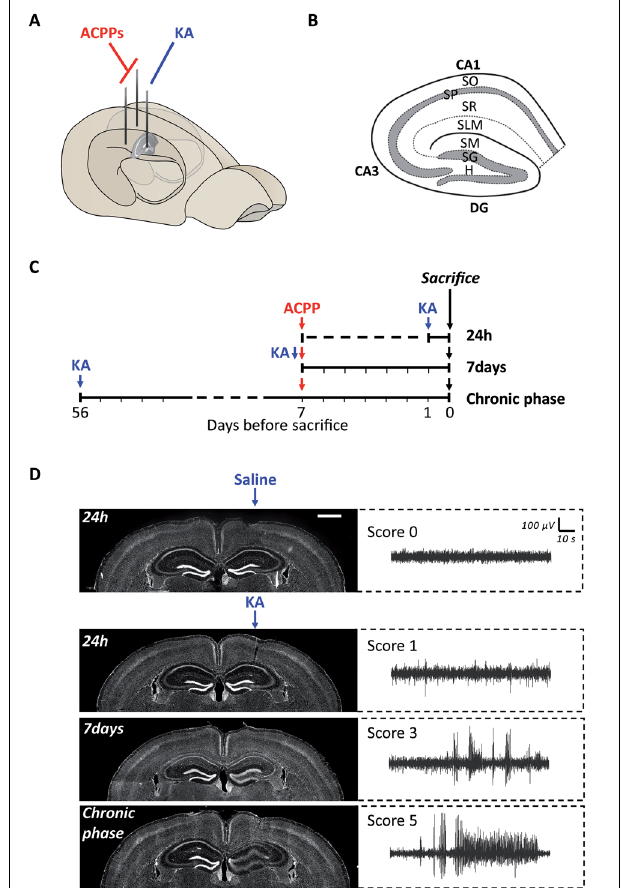
FIGURE 2 | Activatable cell penetrating peptides (ACPPs) can report gelatinase activation by cellular uptake of fluorescence. (A) Structure of ACPPs: a cell-penetrating polycationic part (green) is attached to a polyanionic sequence (orange) via a cleavable linker (blue). In the presence of active gelatinases (MMP-2/-9), the ACPP is cleaved. The cell-penetrating polycationic part coupled to a TAMRA fluorophore is released and can then enter into surrounding cells. (B) Cellular uptake of TAMRA fluorophore induced by NMDA or glutamate transient perfusion. Rat hippocampal neurons (DIV14) were stimulated for 10 min with NMDA (100 µ M) or glutamate (50 µ M), with or without the broad-spectrum Matrix Metalloproteinase (MMP) inhibitor Ca-DTPA (5 mM), then incubated for 2 h 30 in presence of 1 µ M gelatinase ACPPs or an ACCP containing an uncleavable scrambled sequence as a linker (scrambled-ACPP). Hoechst labeled nuclei (blue). Scale bar 20 µ m. (C) Quantification of the number of TAMRA fluorescent cells in gelatinase-ACPP treated cultures in control, NMDA or glutamate stimulated conditions. The graph represents mean values ± SEM ( n > 30 fields for each condition, in three independent experiments). One-way ANOVA test ( p -value = 0.0264) was performed followed by Tukey’s multiple comparison test where ∗ p < 0.05 (control vs. stimulations).